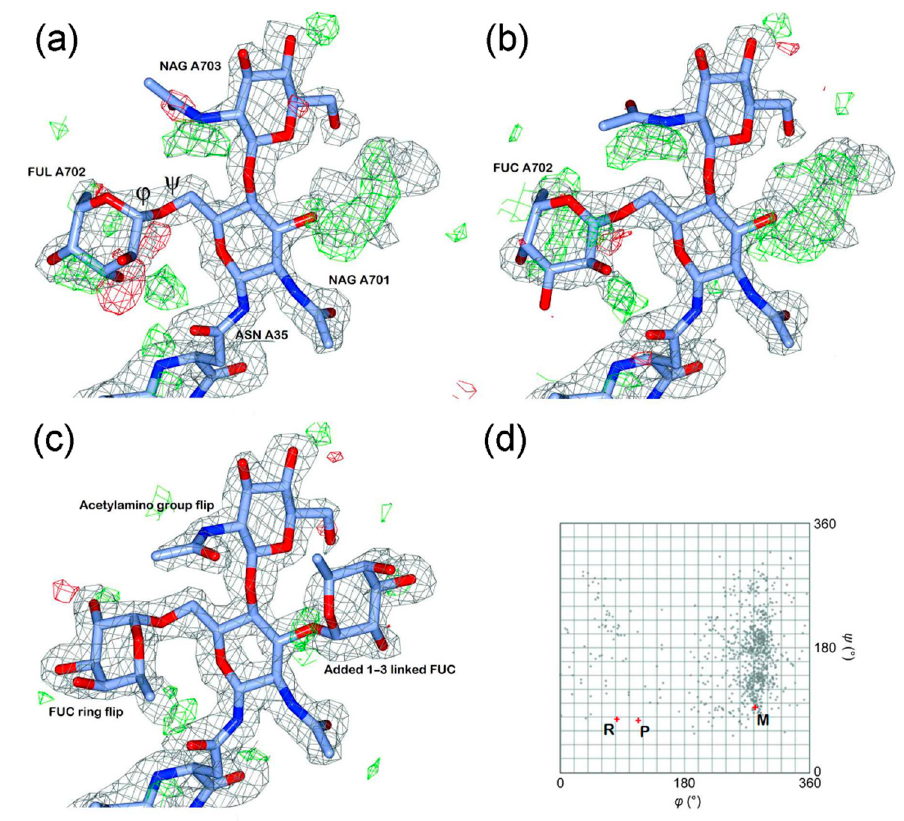
Figure 7. X-ray diffraction data refinement of N-glycan moiety from PDB ID 2Z62. 2mF o –DF c electron density map contoured at 1 σ is displayed in grey; positive and negative mF o –DF c difference electron density maps contoured at 3 σ are displayed in green and red, respectively. ( a ) Original glycan structure model from the PDB entry. ( b ) PDB-REDO model with properly renamed fucose residue and improved fit to the electron density. ( c ) Manually rebuilt model based on PDB-REDO results. ( d ) CARP distribution plot for glycosidic ϕ - ψ torsions of FUC(1-6)NAG (from panel (a)) in PDB. Characteristic points: R, model refined with PDB-REDO; P, original PDB model; M, manually rebuilt model. Reproduced from [295], © 2020 The authors. Published by John Wiley & Sons, Inc.